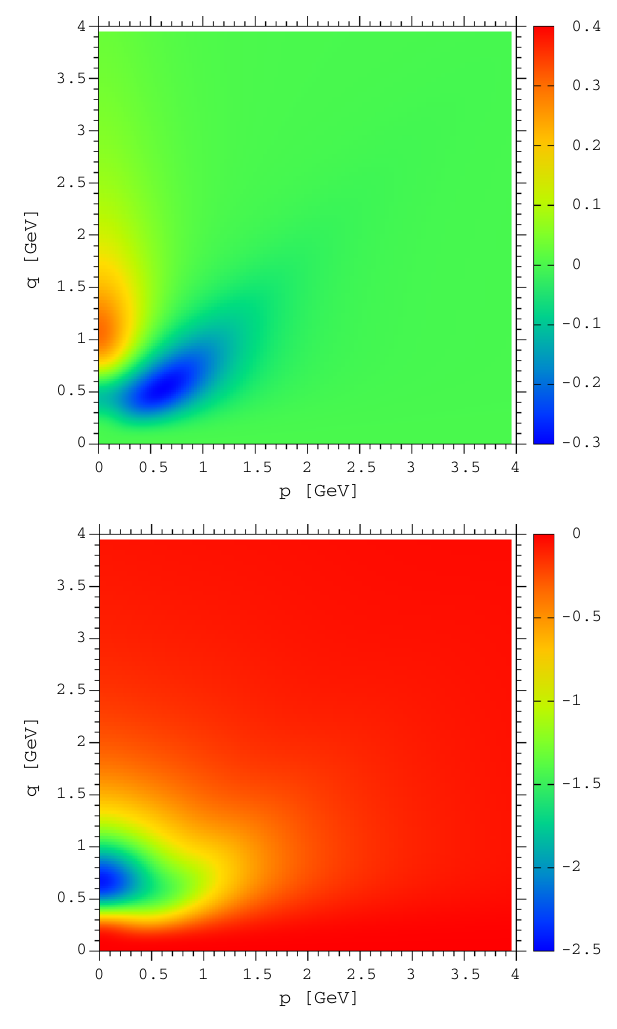
( p , q ) and vector (bottom) B